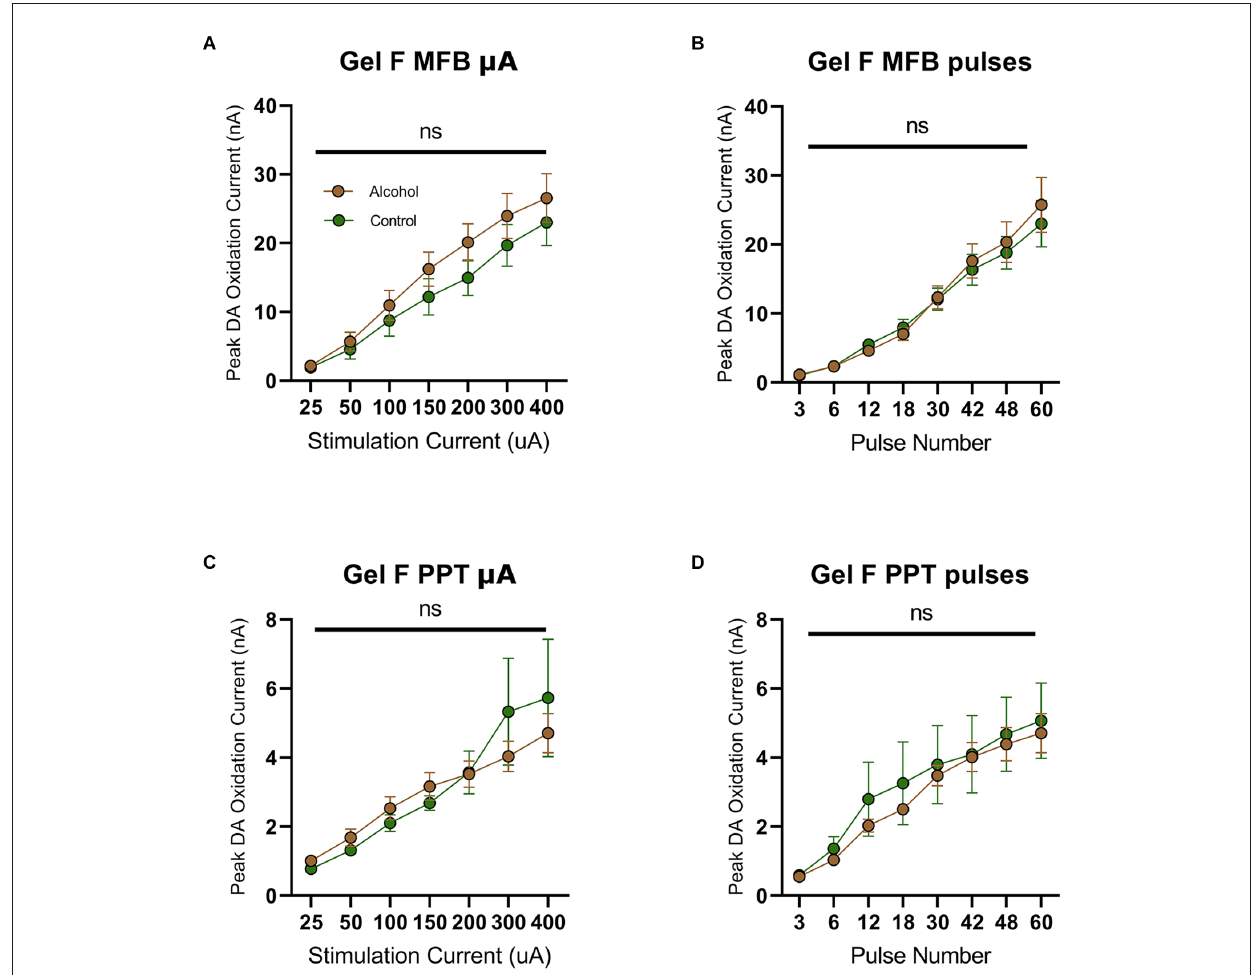
FIGURE4 Peak DA oxidation current (nA) recordings in the NAcc over time after a single electrical stimulation of the MFB (A,B) and PPT (C,D) averaged over varying stimulation currents, pulses, and stimulation frequency for females. (A) Alcohol-exposed ( n = 10) and control ( n = 7) female animals did not significantly differ in phasic DA release in the NAcc after stimulation of the MFB with increasing current (B) Alcohol-exposed ( n = 10) and control ( n = 7) female animals did not significantly differ in phasic DA release in the NAcc after stimulation of the MFB with increasing pulse number. (C) Alcohol-exposed ( n = 10) and control ( n = 7) female animals did not significantly differ in phasic DA release in the NAcc after stimulation of the PPT with increasing stimulation current. (D) Alcohol-exposed ( n = 10) and control ( n = 7) female animals did not significantly differ in phasic DA release in the NAcc after stimulation of the PPT with increasing pulse number. All data are presented as mean ± SEM for the peak DA oxidation current according to stimulation current (25, 50, 100, 150, 200, 300, and 400 nA) and pulse number (3, 6, 12, 18, 30, 42, and 48). ns p > 0.05 for all.